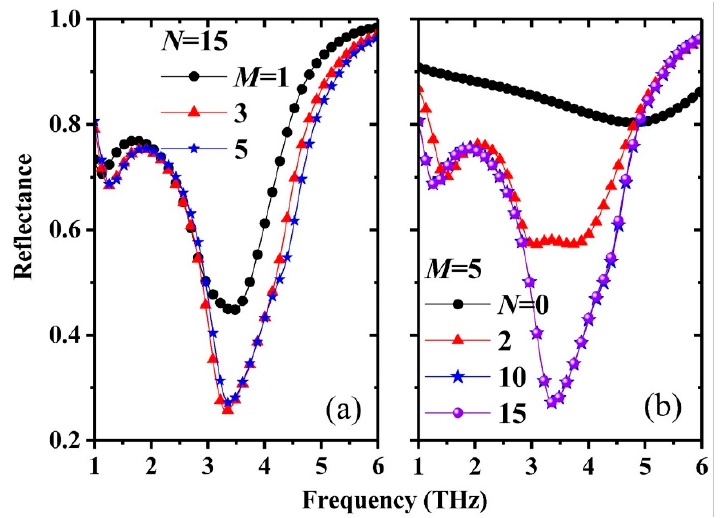
Figure 5. Numerical reflection spectra of the MGDM-graphene structure with parameters of n = 7 × 10 12 /cm 2 and μ = 7500 cm 2 /s/V. The calculations are based the MM with different numbers of waveguide modes and Rayleigh modes. ( a ) Fixed number of Rayleigh modes N = 15 and different numbers of waveguide modes of M = 1, 3, and 5; ( b ) fixed number of waveguide modes M = 5 and different numbers of Rayleigh modes N = 0, 2, 10, and 15.